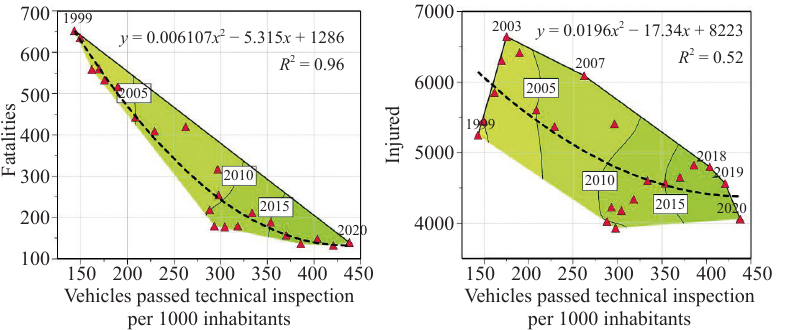
Figure 10. Road fatalities and injuries with the increasing number of cars in use